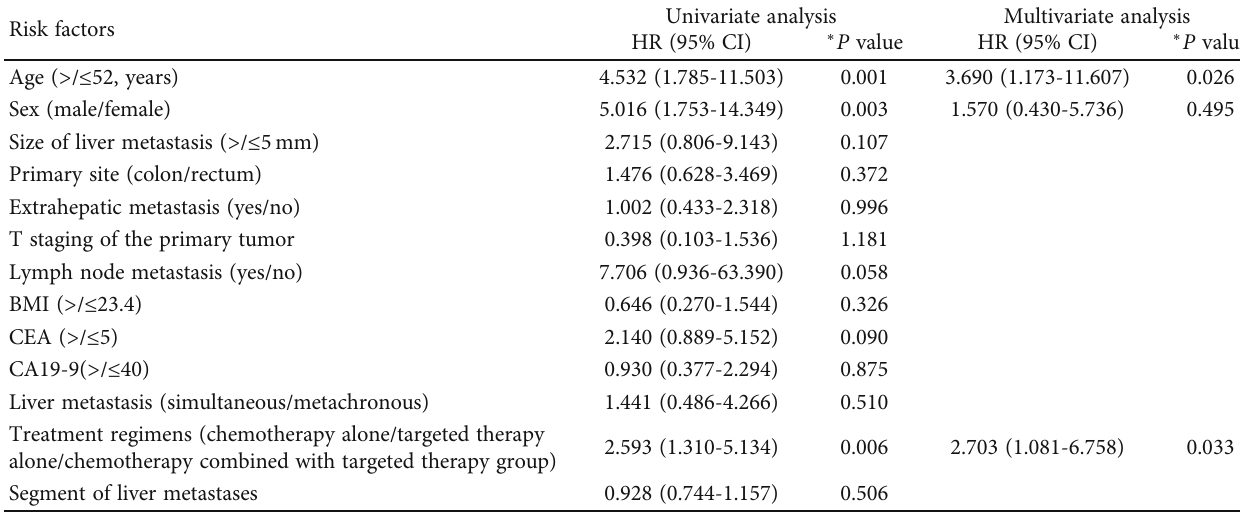
Table 5: Univariate and multivariate analysis of progression-free